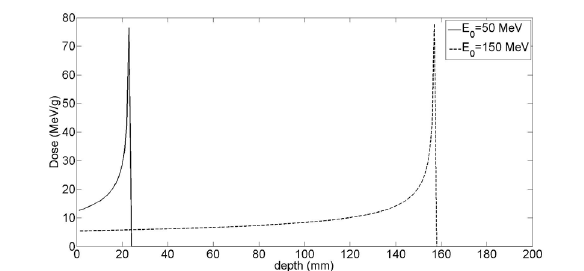
Fig 1. Depth-dose distribution for 50 MeV (solid line) and 150 MeV (dashed line) protons in water.